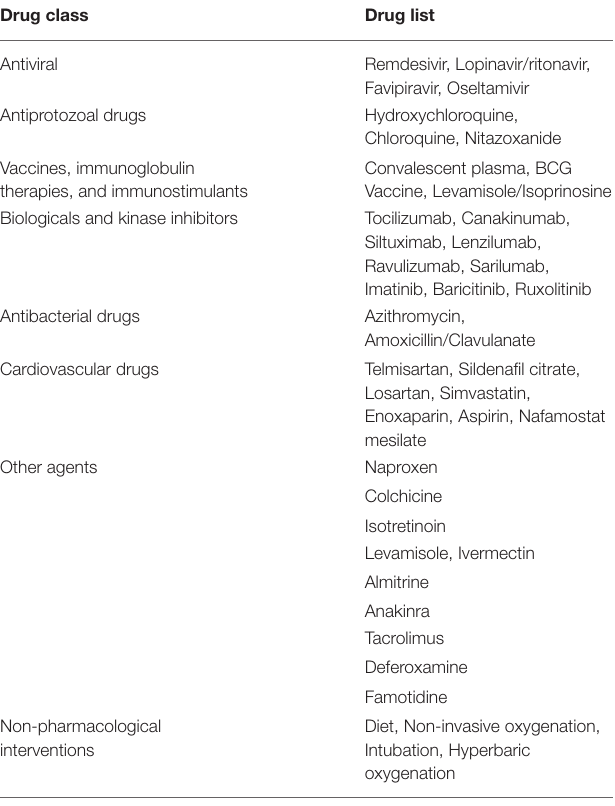
TABLE 1 | List of therapeutic drugs under study for COVID-19 as per clinical trials registered under clinicaltrials.gov. Drug class Drug